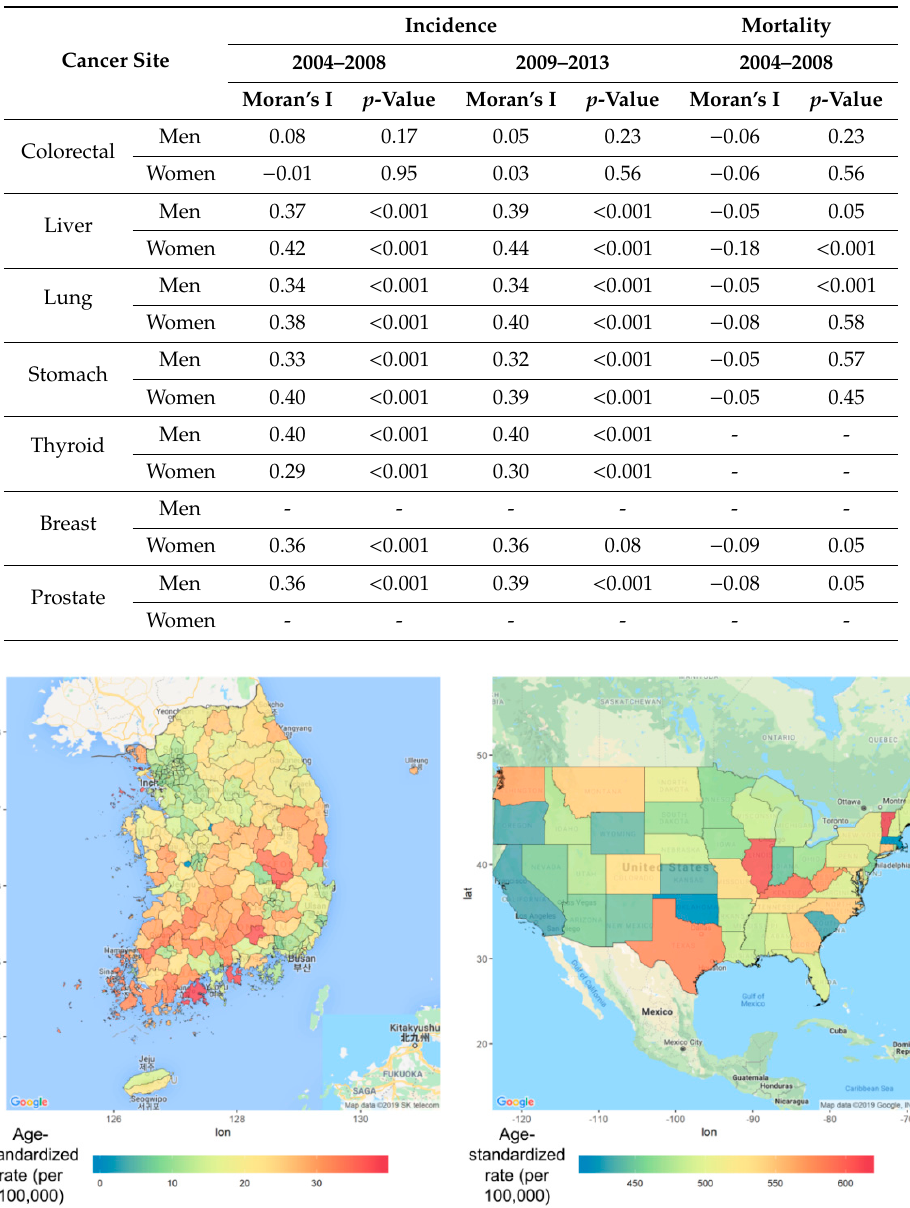
Table 2. Results of Moran’s I statistical test for the incidence and mortality of cancers in South Korea. Incidence Table 3. Comparison of the estimated major cancer incidences (age adjusted) from AEGIS with the Cancer Site findings of relevant published reports.